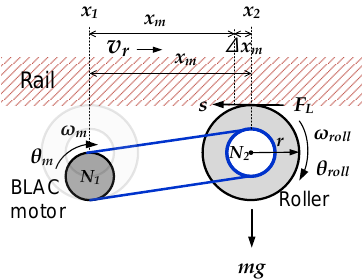
Figure 2. Mathematical model of roller (conventional structure).